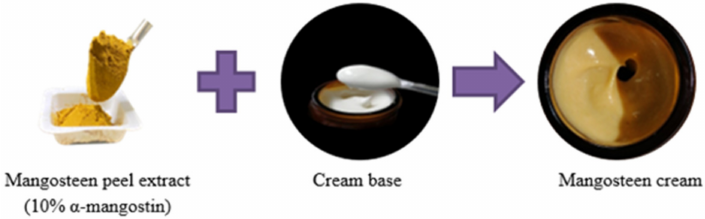
Figure 1. Formulation of mangosteen